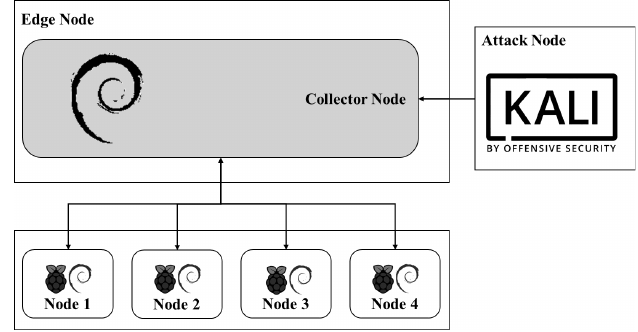
Figure 3. Test scenario.